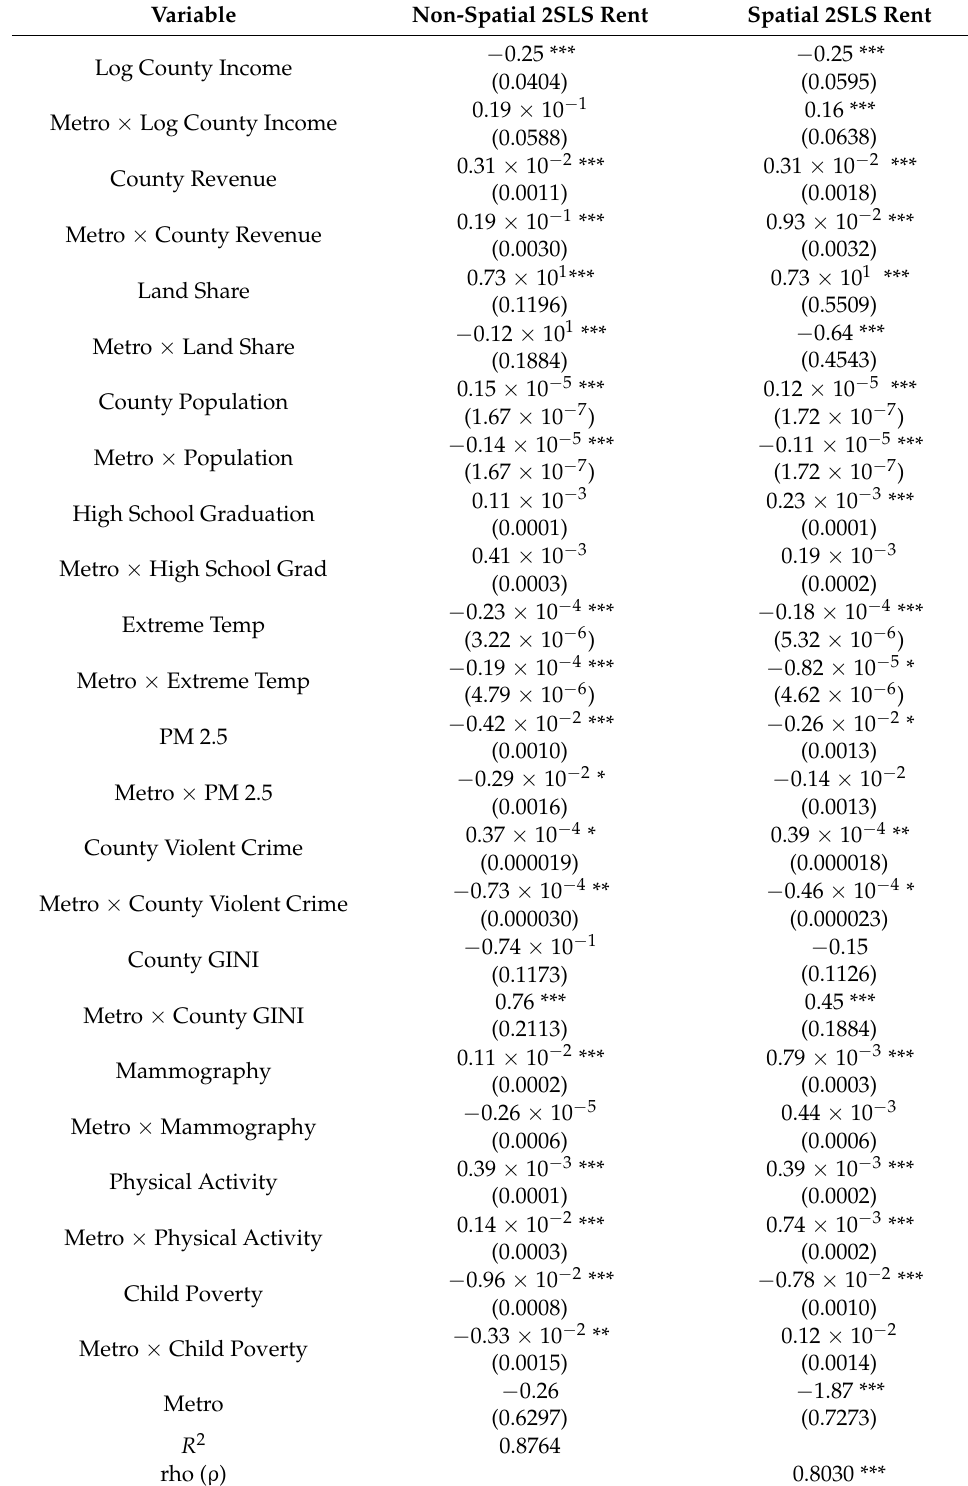
Table A13. Second-stage results for non-spatial versus spatial 2SLS: rent equations with a metro dummy and cross-products for the continental United